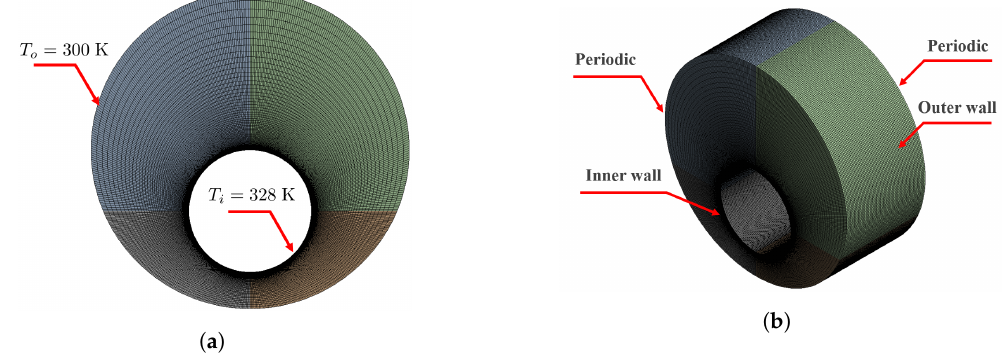
Figure 2. A three-dimensional eccentric cylindrical tube: ( a ) Computational grid and ( b ) Boundary